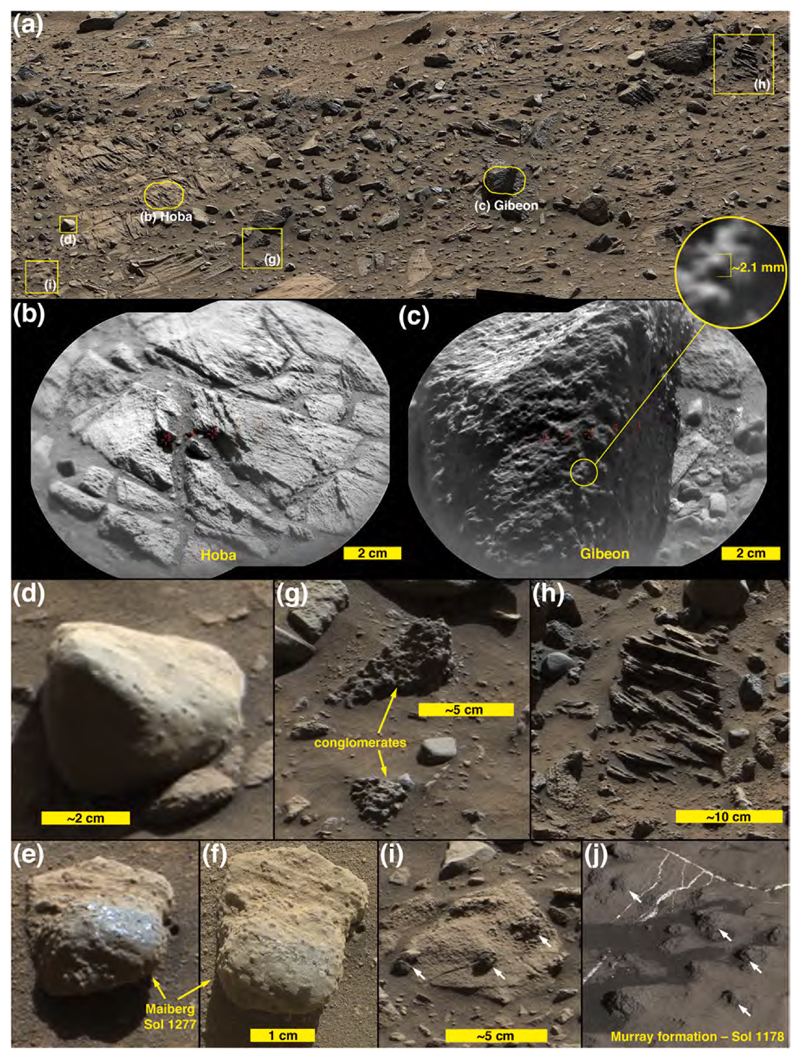
(a) Sol 1160 view of the variety of boulders, cobbles, and pebbles which compose the Brandberg deposit. Outlines indicate locations of panels b, c, d, g, h, and i. (b) Dust-coated, fractured Murray-formation lithic clast target named Hoba. (c) Dark-gray sandstone cobble target named Gibeon. The inset shows enlargement of a single grain or concretion, representative of the larger grains (or typical concretion size) in this rock, ~2 mm. (d) Sandstone with concretions. (e) Example sandstone with concretions (target named Maiberg) liberated from Stimson-formation bedrock on the east side of Naukluft Plateau, imaged on Sol 1277; shown here for comparison. (f) Sedimentary structure and texture details of Maiberg. (g) Examples of candidate, rare conglomeratic stones at Brandberg. (h) Example of angular, cobble-sized fragment of cross-bedded sandstone. (i) Example lithic fragment of Murray-formation bedrock incorporated into the Brandberg deposit; white arrows indicate erosion-resistant concretions; compare with (j): Example of intact Murray-formation bedrock south of Brandberg which contains similar concretions (white arrows).